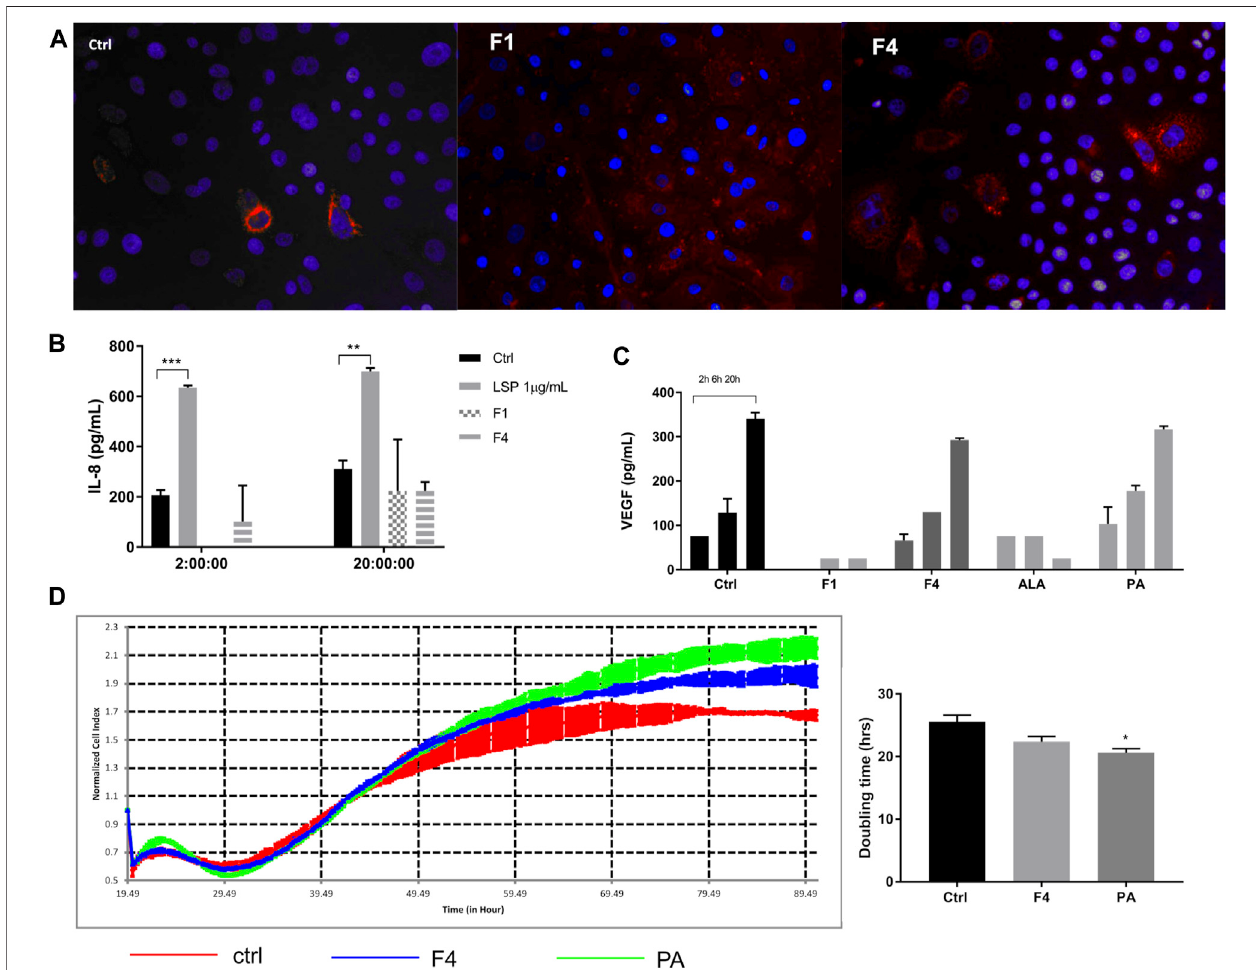
FIGURE 3 | Investigation of selected puri fi ed fraction effect on human normal keratinocytes. Assessment of ALA- and PA-enriched fractions uptake of normal keratinocytesbyOilRedshowedgoodcellularpenetrability (A) .Treatmentwithpuri fi edfractionsdidnotinduceanin fl ammatoryresponse,asassessedbyELISAforIL-8 (B) .VEGFexpression,assessedbymultiplexing,showedthatF4anditscorrespondingFAanalyticalstandard(PA)followedthesametrendasthecontrol (C) .Long-time monitoring of the cell index using real-time impedance reading combined with doubling time analysis showed that PA signi fi cantly stimulates cell proliferation of normal human keratinocytes (D)